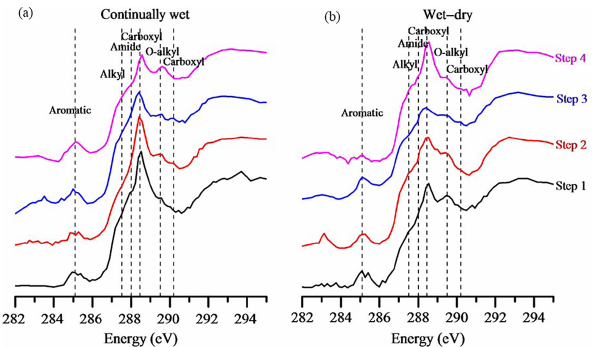
Figure 7. C NEXAFS extracted from C (red in Fig. 6) regions of STXM map for the second step of the continuously wet treatment (a) and from all four steps of the wet–dry treatment (b) . For color rendering of this image please refer to the online